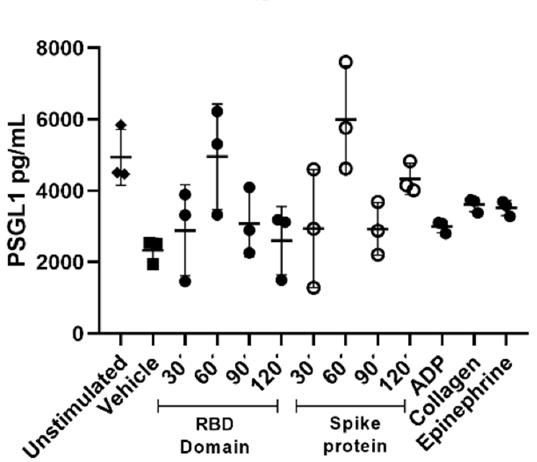
Figure 4. The spike protein and its RBD domain stimulate platelets’ release of pro-inflammatory factors. Comparison of supernatant concentration of ( A ) IL-6, ( B ) IL-8, ( C ) sCD40L, ( D ) P-selectin and ( E ) PSGL-1 in PRP incubated with spike full-length protein (2.0 µ g/mL) and RBD domain (2.0 µ g/mL) at different times. Known platelet aggregation agonists were used as activation controls (20 µ M ADP, 20 µ M collagen, and 100 µ M epinephrine), Tyrode’s buffer was used as vehicle and PRP treated under the same conditions but without external stimuli as a negative control. p values were calculated using one-way ANOVA and Tukey’s post-hoc tests ( n = 3). Data presented as Mean ± SD. Statistical difference * p < 0.05, ** p < 0.01, *** p < 0.001, **** p < 0.0001.